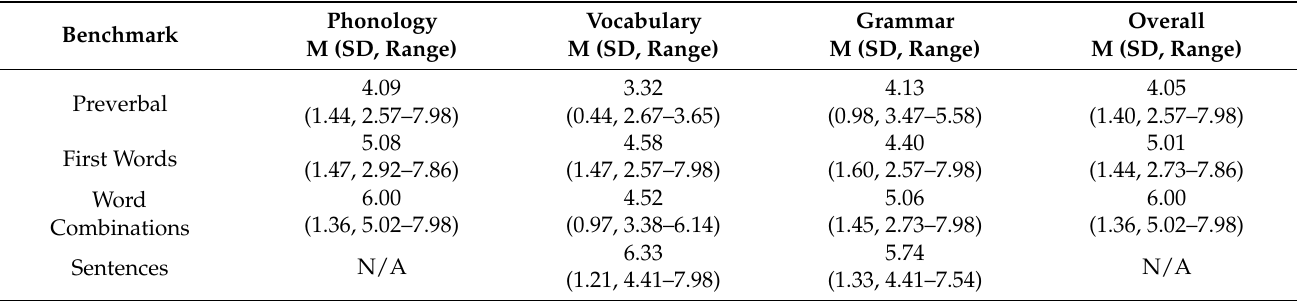
Table 3. Descriptive Statistics for the Chronological Ages (in Years) of Children Assigned to the Expressive Language Benchmarks as a Function of Language